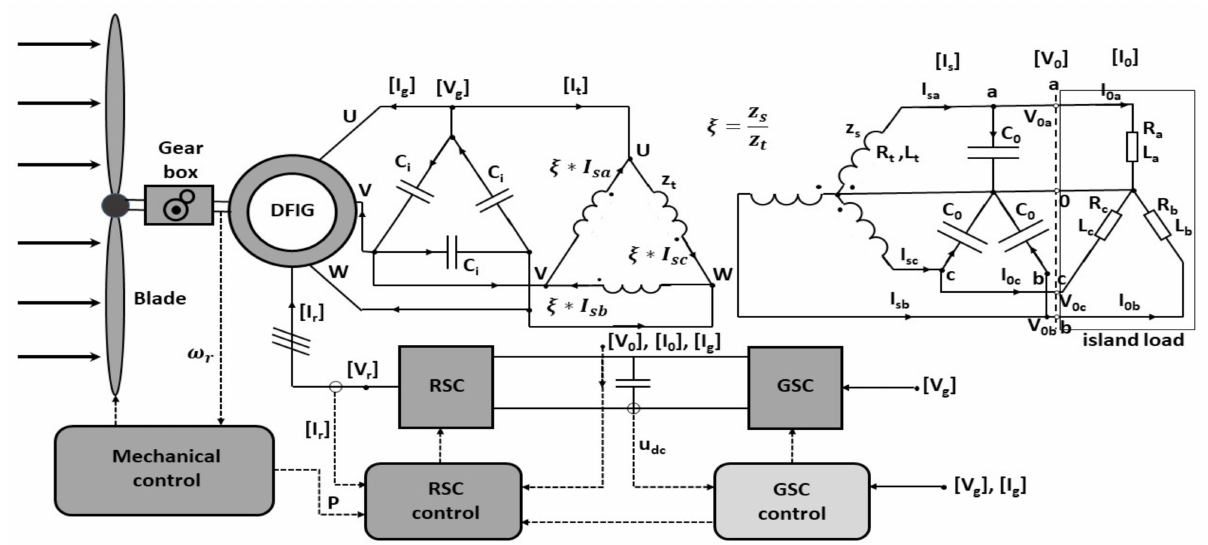
Figure 1. The considered system of DFIG generator of a wind turbine in islanded grid